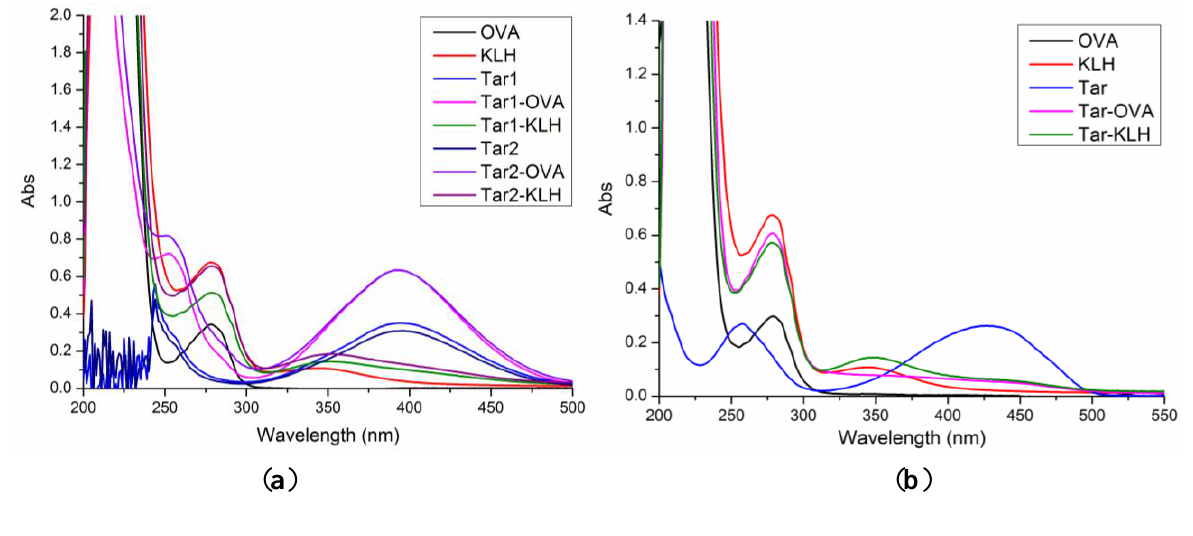
Figure 1. ( a ) UV absorption spectra of hapten 1 and hapten 2 conjugates; ( b ) UV absorption spectra of hapten 3